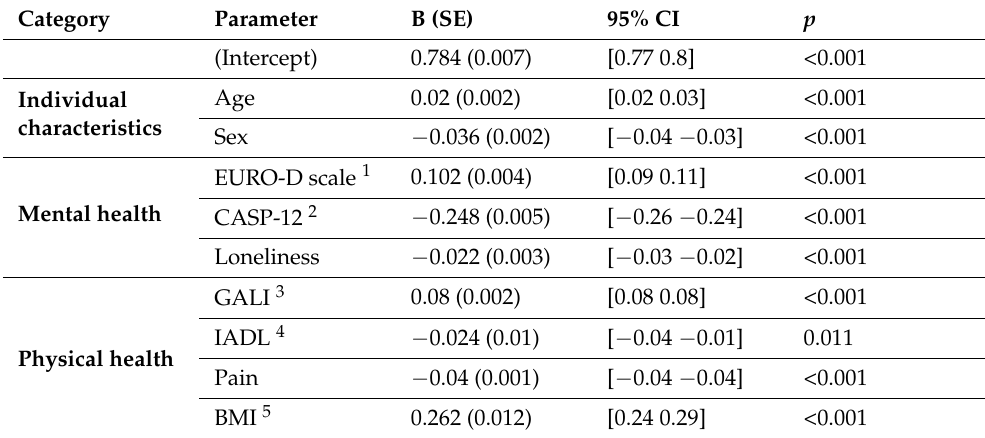
Table 5. Self-Perceived Health estimation: Overview of the model coefficients by category. Note. Adjusted R 2 = 0.47. CI = Confidence Interval for